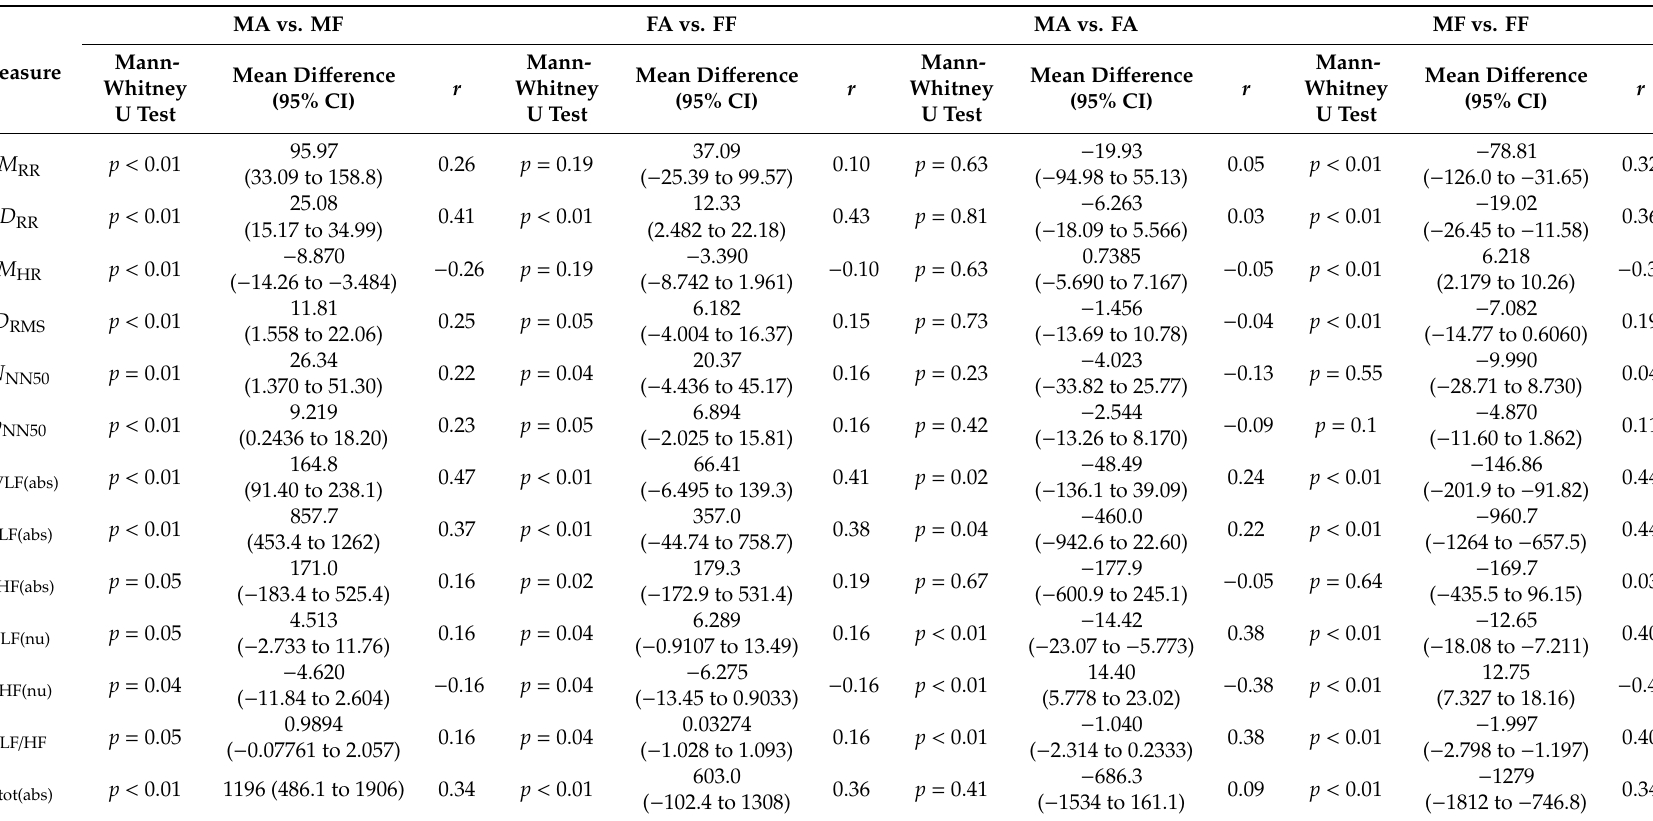
Table 6. Results of Mann-Whitney U tests of HRV time and frequency domain measures of drivers with di ff erent mental states and of di ff erent sexes. MA vs. MF FA vs. FF MA vs. FA MF vs. Measure